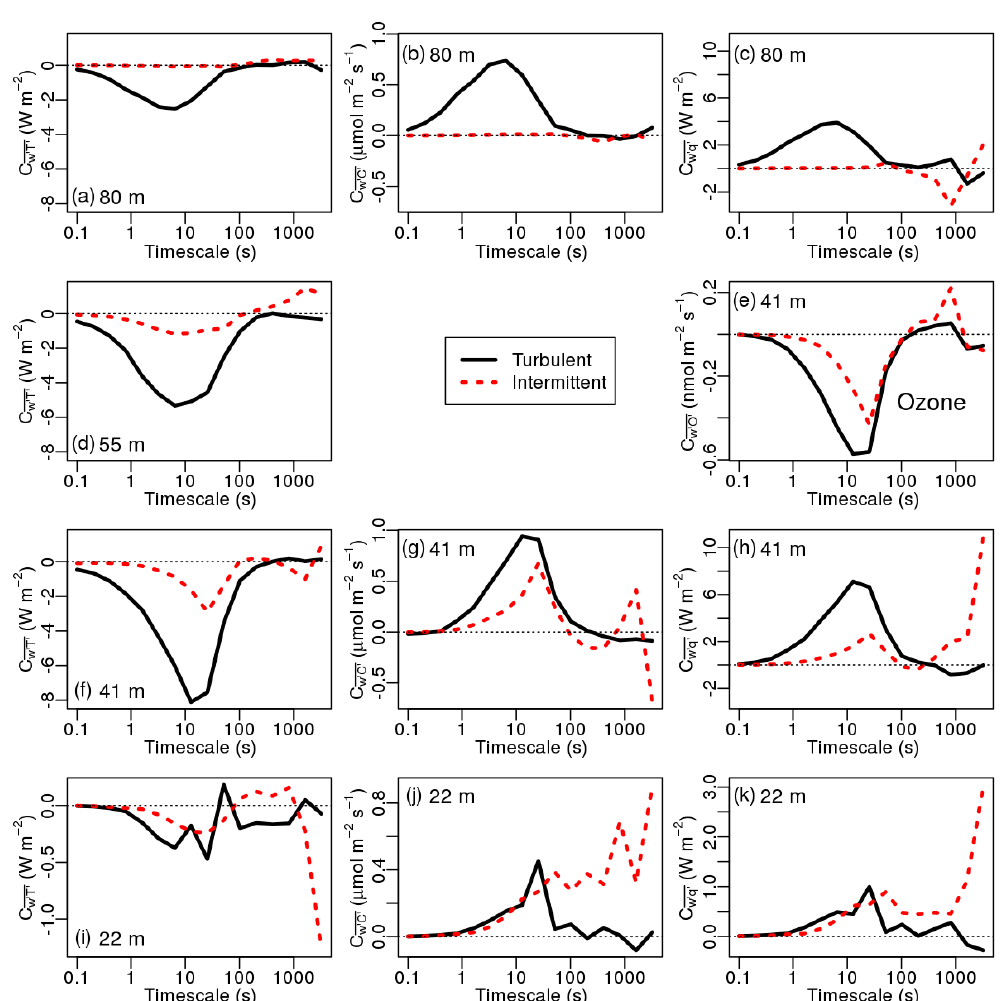
Figure 7. Average cospectra of sensible heat ( a , d , f , i ), CO 2 ( b , g , j ), O 3 (e) , and latent heat fluxes ( c , h and k ) for the turbulent night (black solid lines) and the intermittent night (red dashed lines) for all levels, as indicated in each panel. In all panels, averages are calculated for each